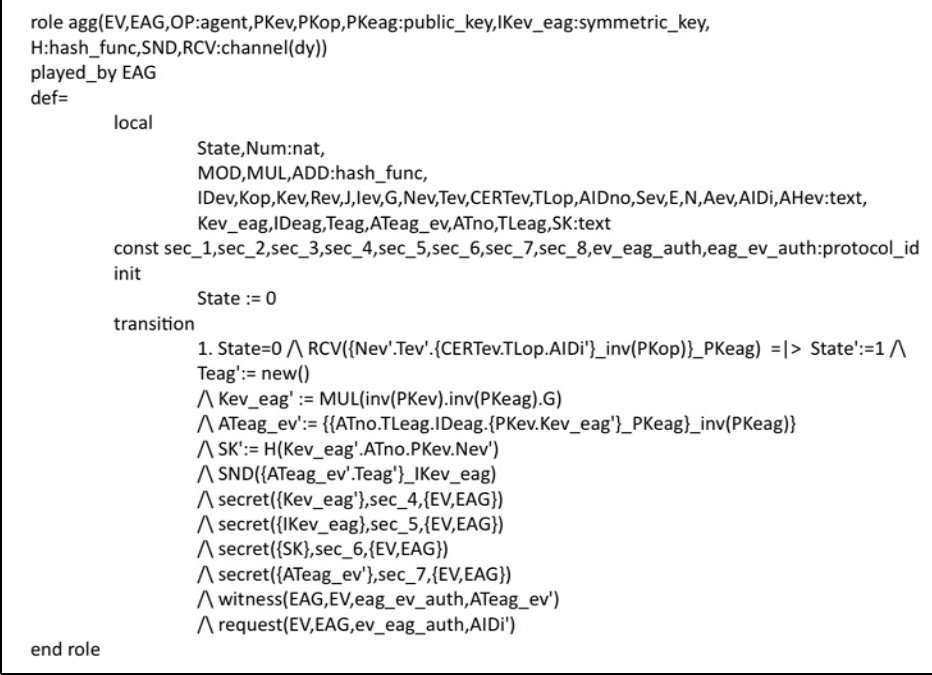
Figure 9. Mutual Authentication Specification of EAG.